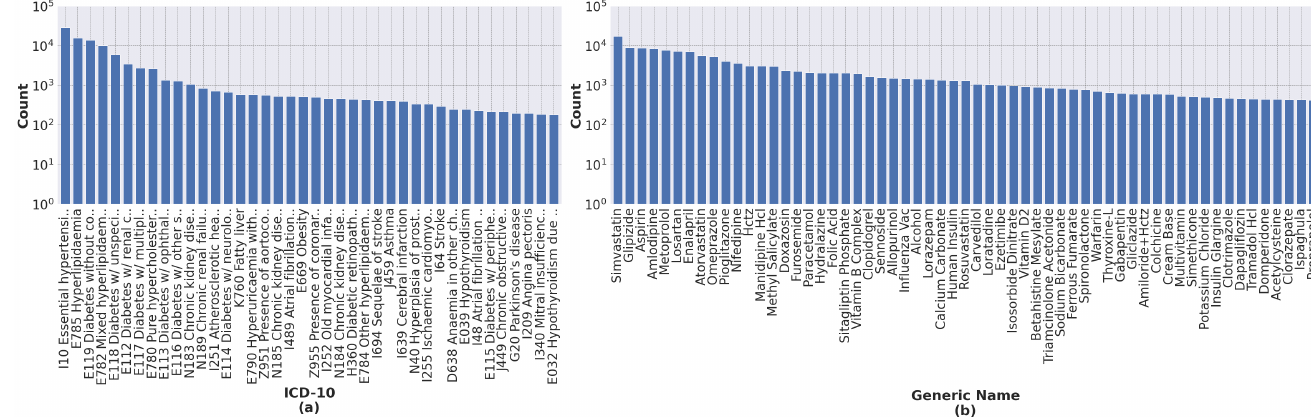
Figure 2. Distribution of ( a ) ICD-10 codes and ( b ) drugs’ generic names for the 40 most frequent ICD-10 codes and the 60 most frequent generic names of drugs in the dataset. All chosen features have at least 200